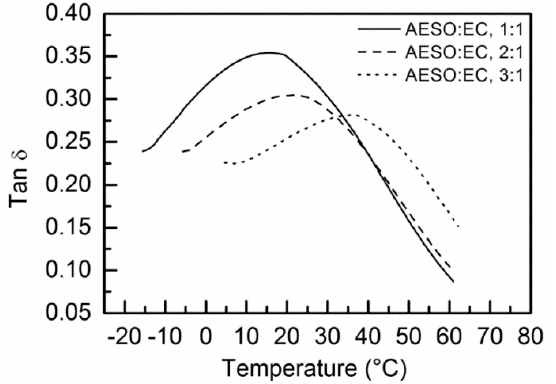
Figure 8. Tan δ as a function of temperature for AESO-EC thermosets.